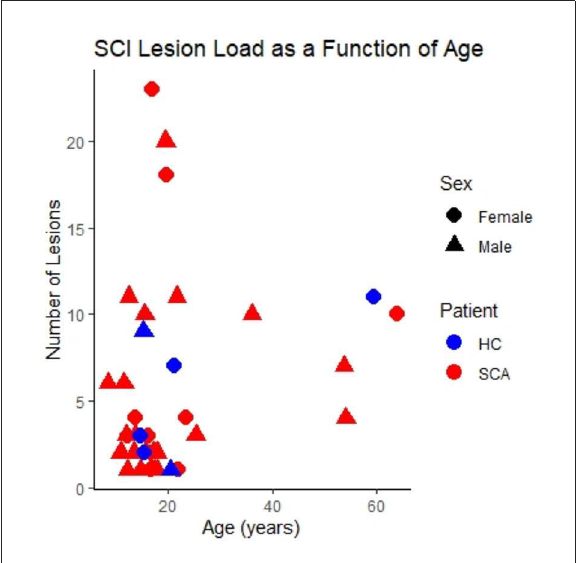
FIGURE2 SCI lesion count. The number of silent cerebral infarcts (SCI) segmented in each participant as a function of age, sex, and sickle cell status in the study cohort. Lesions were defined according to the FLAIR-based SIT trial definition. This is the case for all subsequent figures unless indicated